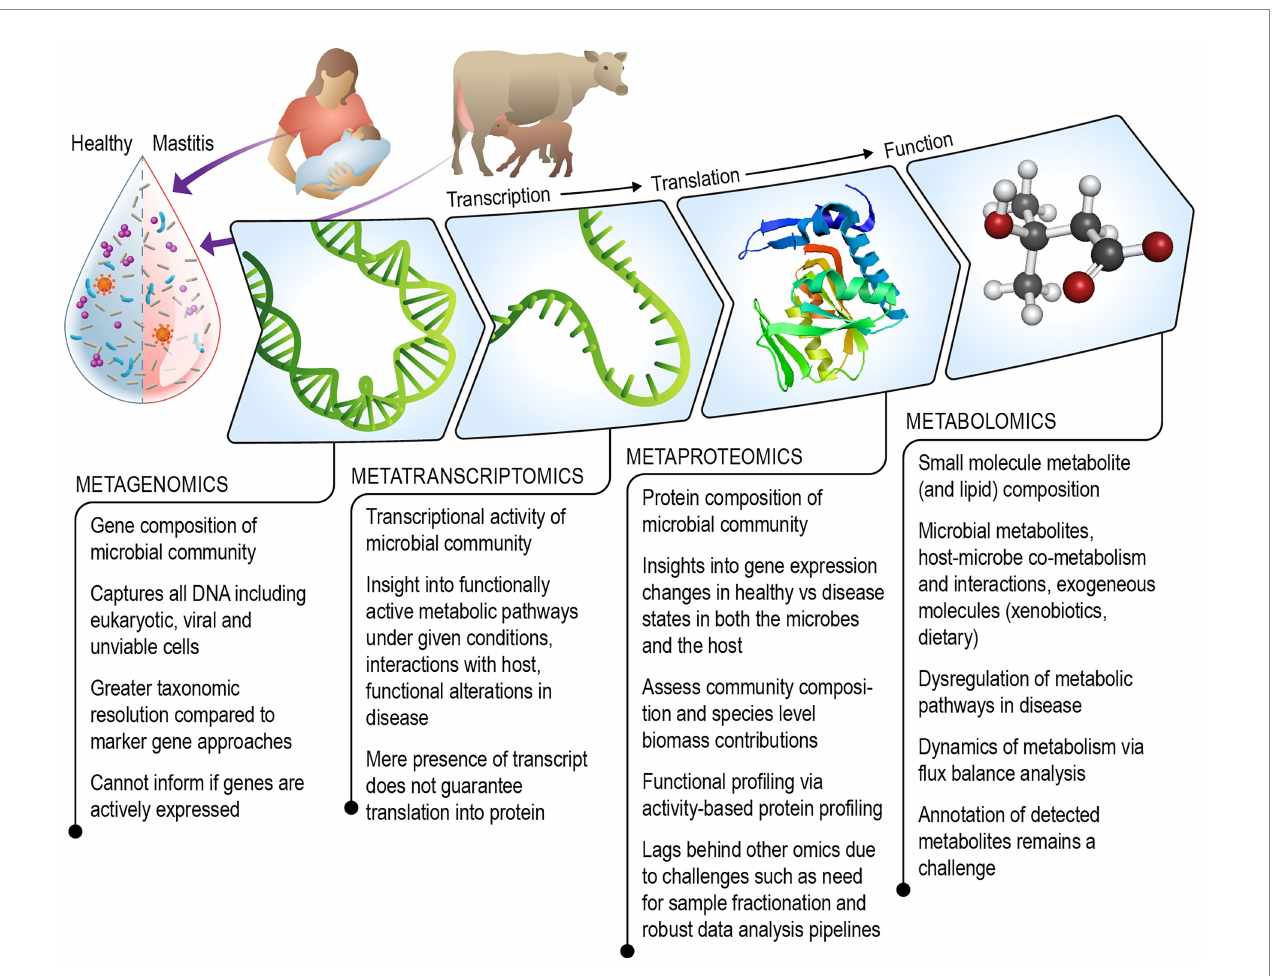
FIGURE 1 Schematic illustrating the combined multi-omics technologies that can be leveraged to gain a mechanistic understanding of the role of the milk microbiome in the onset and progression of mastitis in humans and agricultural